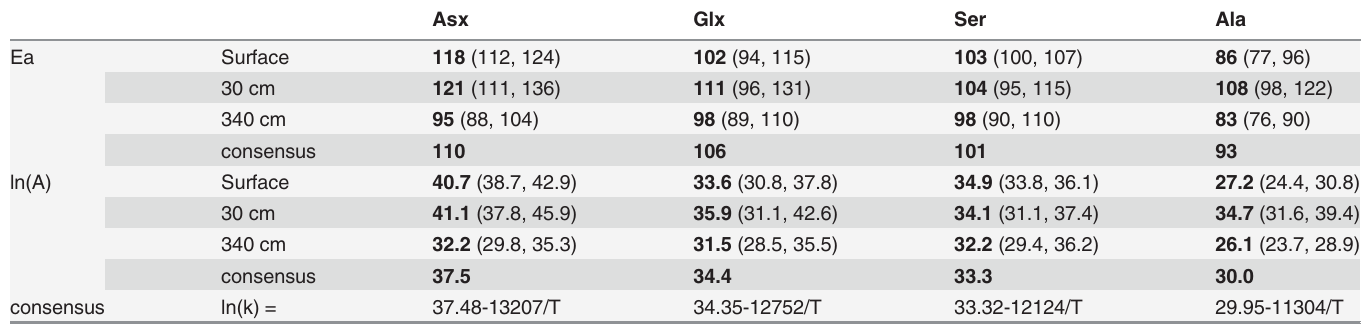
Table 2. Activation energies, E a , kJ mol − 1 ; frequency factors (ln A), yr − 1 ; and consensus Arrhenius equations for racemization rate constants (in which temperature T is in K and k is yr − 1